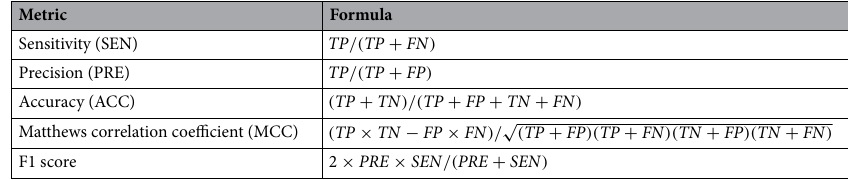
Table 2. Metrics formulas.